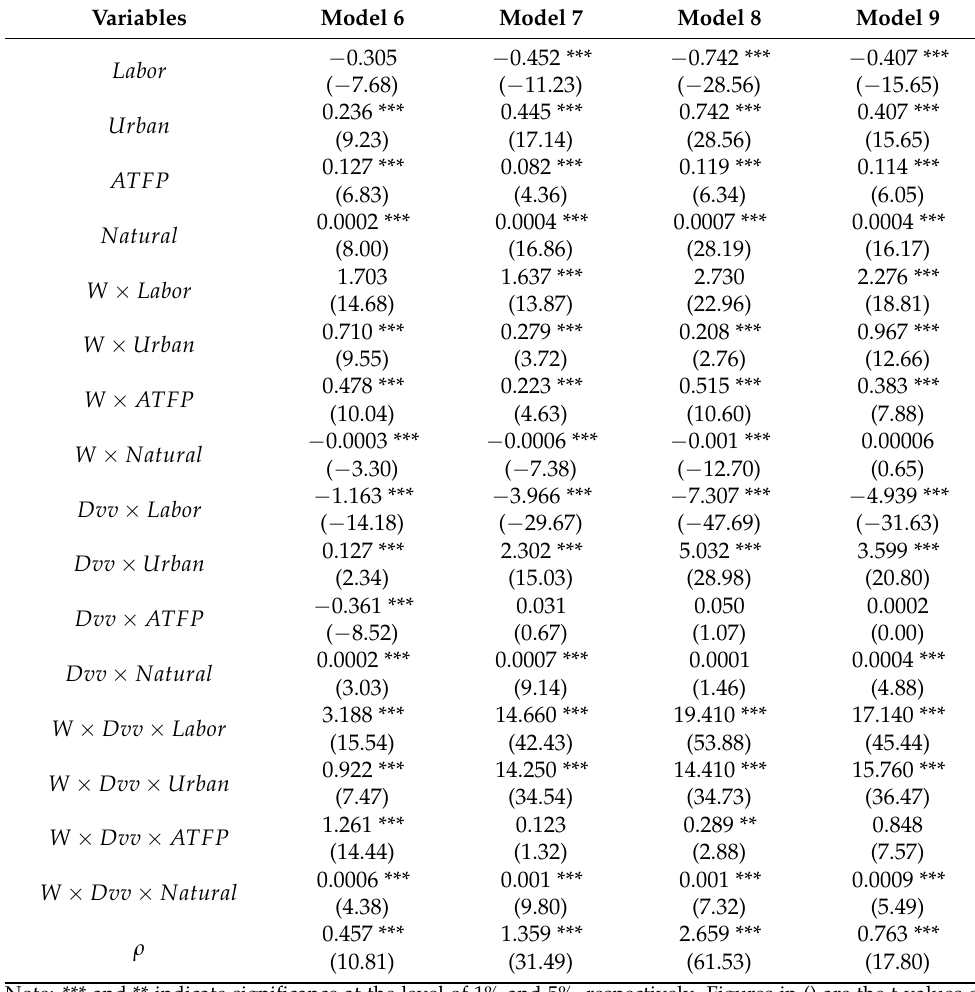
Table 5. Influence mechanism of TPEFAP on